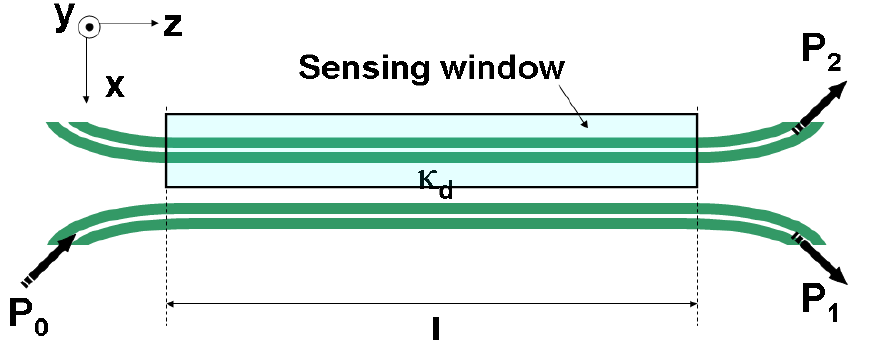
Figure 8. Schematic top view of a directional coupler formed by slot-waveguides. Variation of the refractive index in the sensing region alters both P is the coupling coefficient between the κ d